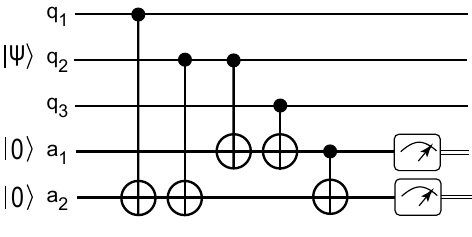
Figure 16: Circuit to generate an error syndrome in two ancilla qubits, using three-qubit en- coding. The three communication qubits ( q one another using the two ancilla qubits ( a kind of circuit does what is called a “parity check.”